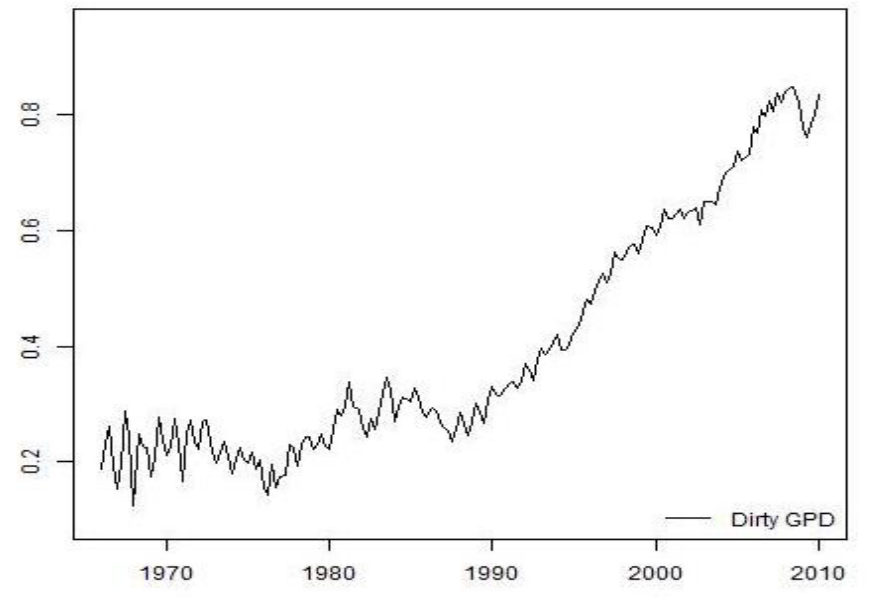
Figure 1. Quarterly dirty GDP. Table 4. Information about the estimated model of state space by Benchmarking.